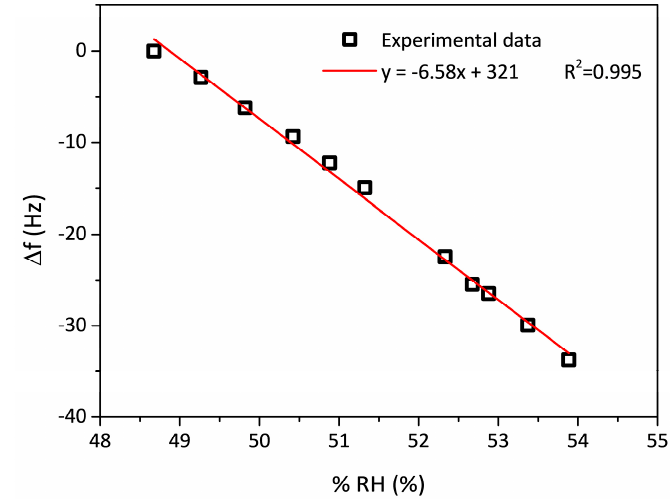
Figure 3. The resonant frequency shift of chitosan-based QCM alcohol sensor under the influence of different RH values.